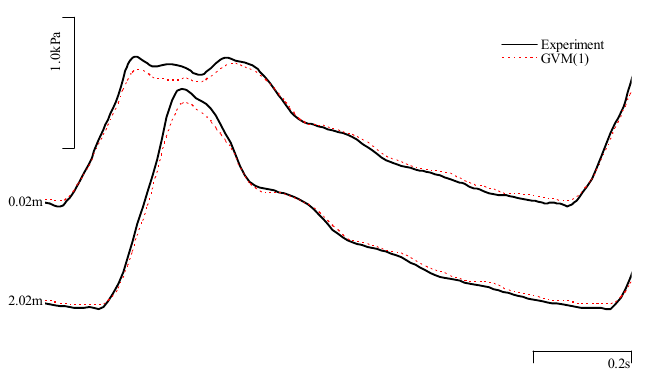
Fig. 8 Calculated pressure waves (dotted red line) compared with the measured waves (bold black line) at two locations in the tube